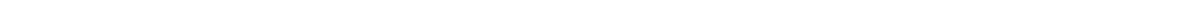
Fig. 3 Duplications of STE1-extended region are initiated at homologous repeated sequences. a Position of the restriction sites in the telomeric and subtelomeric regions within pNSU70 and pNSU64. Homologous repeated sequences (HRS) are marked in red. Primers within or fl anking HRS that are used for quantitative PCR are represented: p Apa I, p Swa I, and p Nsi I. b Quantitative PCR analysis of subtelomeric regions in ter1 + and ter1 Δ cells. Cycling ter1 + (Repl) or ter1 Δ cells that were collected during replicative senescence (Sen) were shifted in deprived-nitrogen medium for 1, 4, and 8 days (G0D1, G0D4, and G0D8). Fold enrichment corresponds to the ratio of subtelomeric signal over genomic control signal (Methods section). Error bars indicate the SEM from three independent quantitative PCR. c Schematic representation of a natural telomere and the transcription-inducible telomere (tiTel). The nat r :Pnmt1 cassette was inserted in the left arm of chromosome II. The integrated cassette contains a new Hind III restriction site, while the natural Apa I site is disrupted upon integration. Speci fi c tiTel probe (nmt1) and HRS are indicated. d STEEX formation at the tiTel . tiTel ter1 Δ cells were collected after 59 pds during replicative senescence and shifted to deprived-nitrogen medium. Cells were collected after the indicated days (1, 4, and 8) in quiescence. Genomic DNA was digested with Hind III and analyzed by southern blot with a nmt1 probe. R corresponds to tiTel ter1 + cells collected during replicative growth. Asterisk marks the nmt1 endogenous locus. e Schematic representation of nat r :Pnmt1 cassette duplication (tiSTEEx). According with this scheme, Hind III- digestion of rearranged tiTel generates fragments of 4.2 Kb. The combination of tiSTEEx and natural STEEx lead to accumulation of ti/natural STEEx of heterogeneous size visualized as a smear with the nmt1